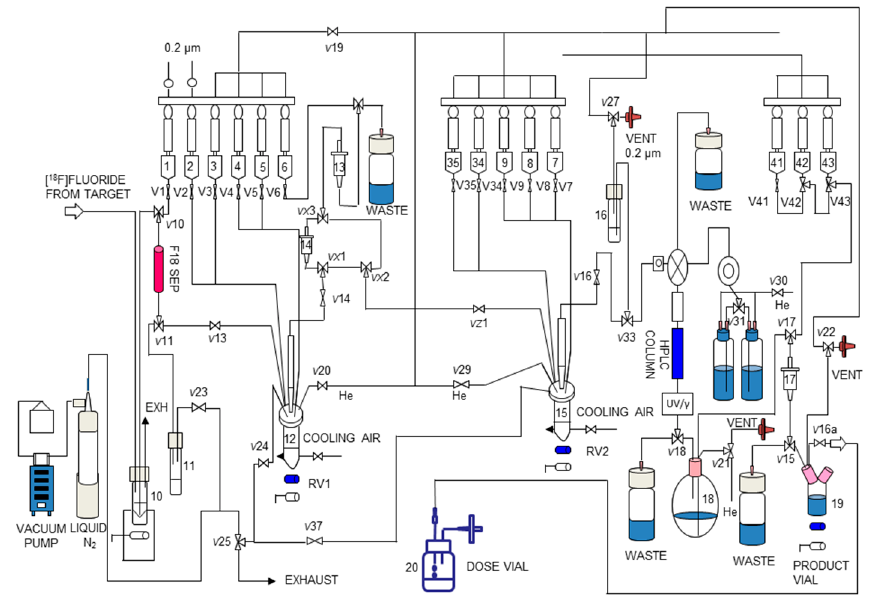
Figure 4. Schematic of the TRACERLab ® FXN Pro automated module for radiosynthesis of [ 18 F]DHMT. Reaction Sequence